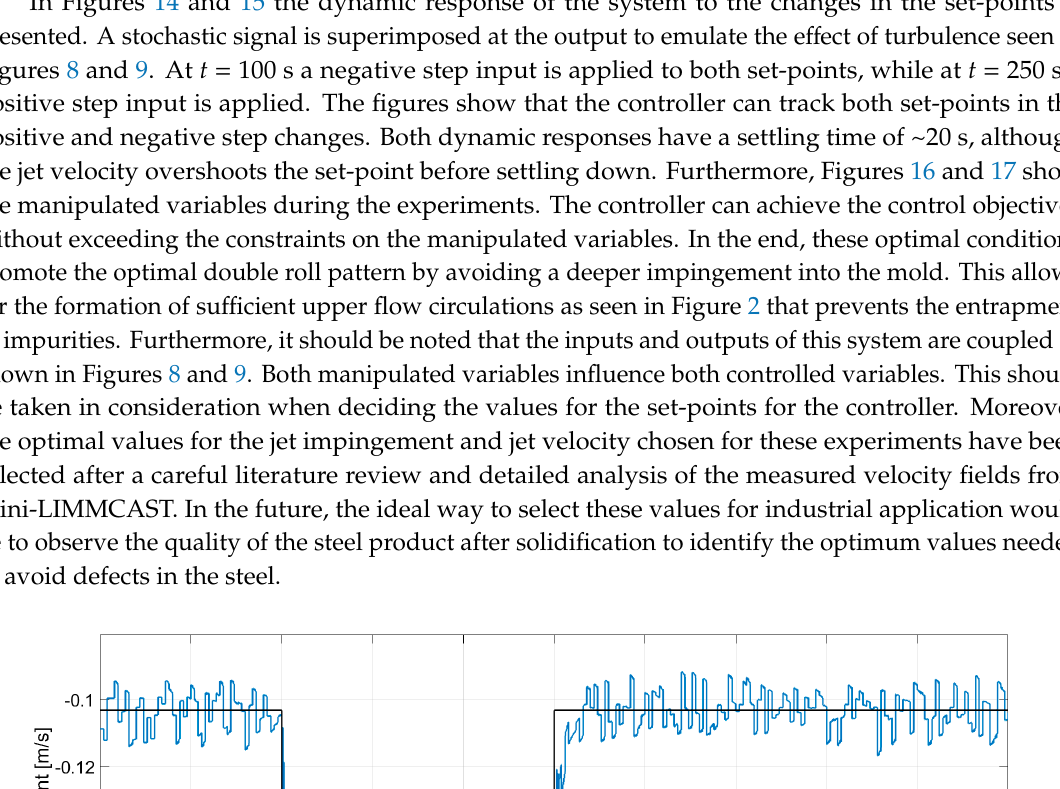
Figure 13. Control loop based on measured velocity profile from ultrasound Doppler velocimetry.